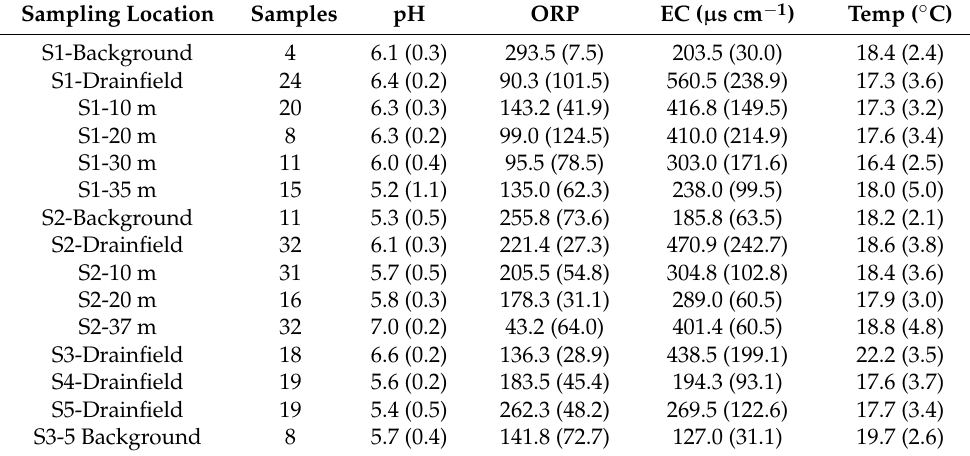
Table 4. Mean and standard deviation of pH, oxidation–reduction potential (ORP), electrical conduc- tivity (EC), and temperature for Site 1 (S1), Site 2 (S2), Site 3 (S3), Site 4 (S4), and Site 5 (S5). Samples were collected from groundwater downgradient (10 m, 20 m, 30 m, 35 m, 37 m) from the drainfields at S1 and S2 and in background locations not influenced by the